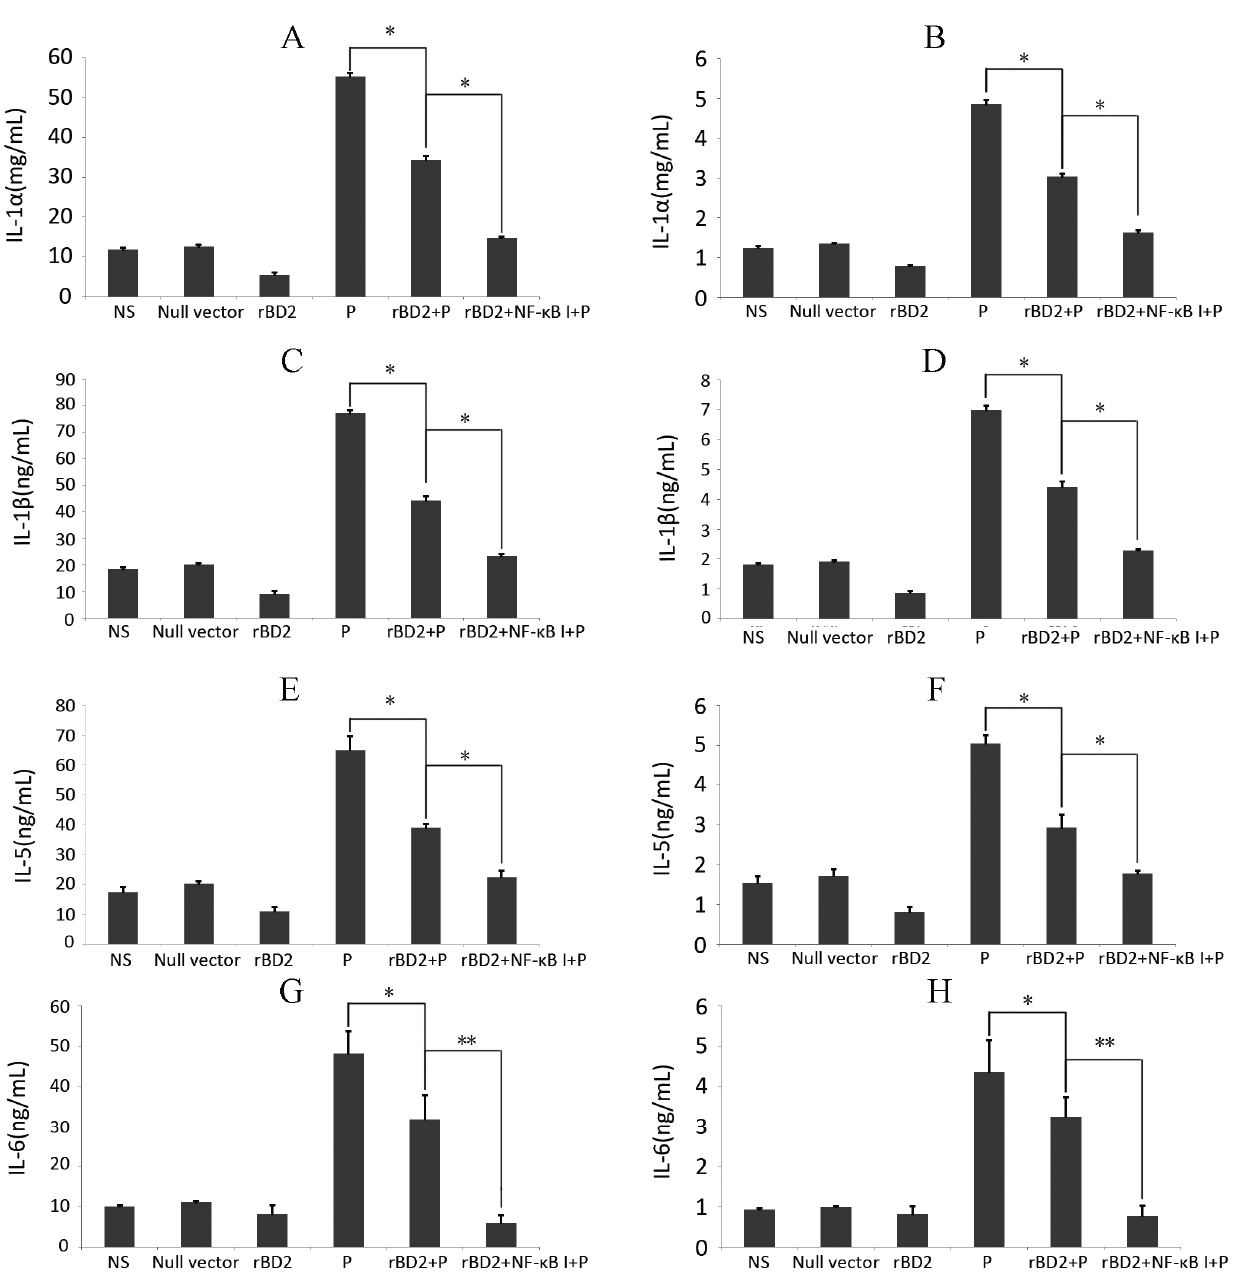
Figure 5. Effects of rBD2 on proinflammatory cytokines. Quantitative analysis of IL-1 α and TNF- α ( M , N ) in lung tissue homogenates ( A , C , E , G , I , K , M ) and peripheral blood samples ( B , D , F , H , J , L , N ) in each group. Data were expressed as mean ± SD ( n = 6). Groups: normal saline group (NS), group treated with null lentivirus (null vector), Pseudomonas aeruginosa infected group (P), group treated with rBD2 expression lentivirus ( rBD2 ), Pseudomonas aeruginosa infected group pretreated with rBD2 expression lentivirus ( rBD2 + P), group pretreated with rBD2 expression lentivirus and the inhibitor of NF- κ B ( rBD2 + NF- κ B I). * p < 0.05, and ** p <